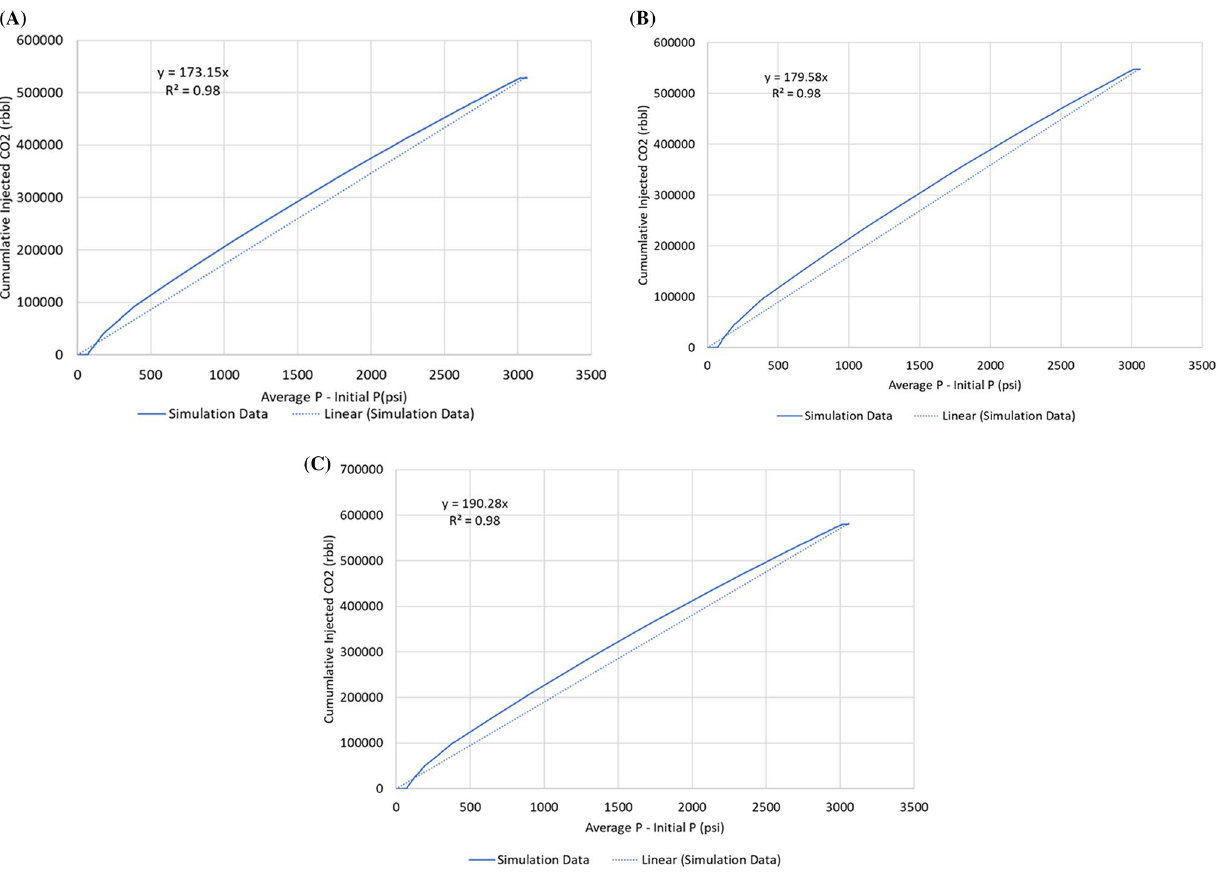
Fig. 5 Predicted cumulative injected CO 2 versus average pressure for oil-saturated reservoir using numerical simulation and applied linear regression using Eq. 2 for a Case 1, b Case 2, and c Case